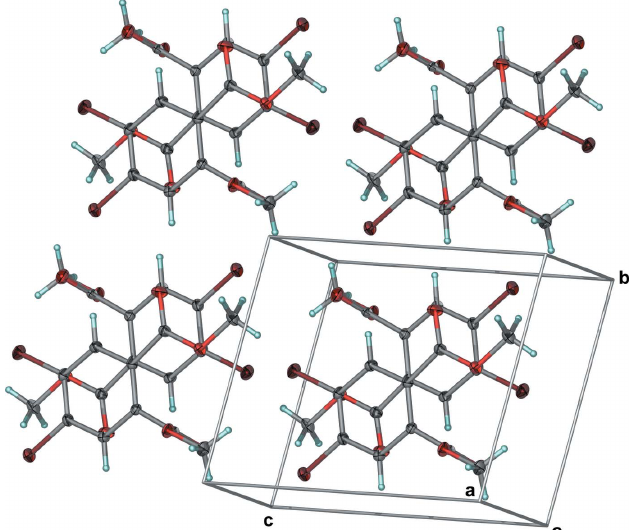
Figure 2 Solid-state expansion of 1 showing the superposition of the electron-rich aromatic ring centroid and the electron-deficient carbonyl carbon atom. Anisotropic displacement ellipsoids have been set to the 50% probability level.